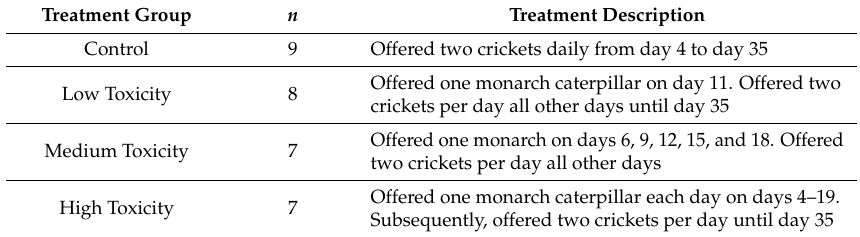
Table 1. Description of mantid treatment groups and the number of individuals in each